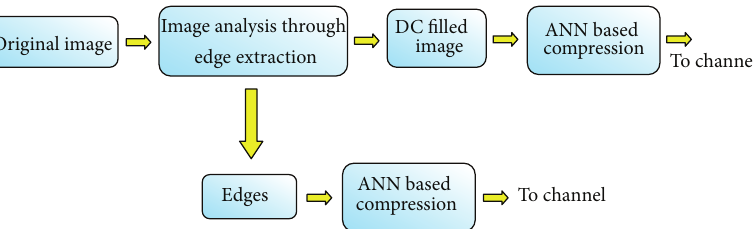
Figure 1: Block diagram of proposed image compression scheme–encoder.